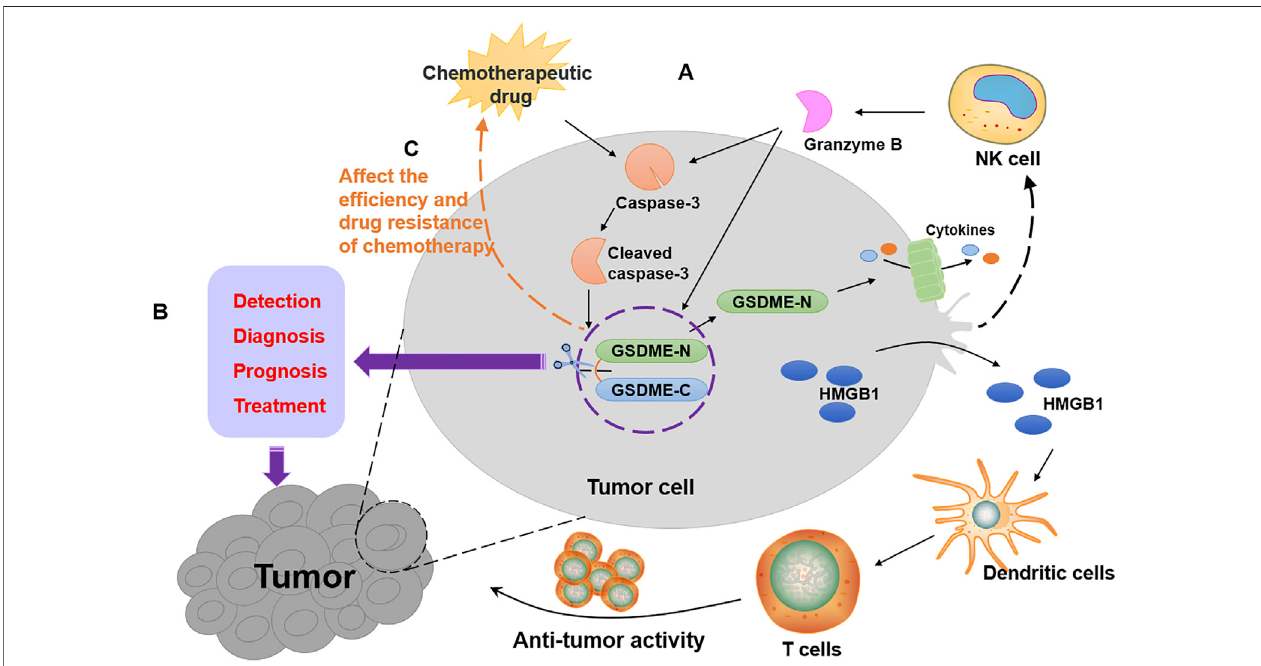
FIGURE 2 | The role of GSDME in tumors. (A) The ways of tumor suppression by GSDME as shown by the black arrows in the fi gure. Chemotherapeutic drugs activate caspase-3 to form cleaved caspase-3, which leads to the cleavage of GSDME. The GSDME-N targets cell membrane to form pores, resulting in cancer pyroptotic cell death. Furthermore, granzyme B released by NK cells not only activates caspase-3 but also directly cleaves GSDME to cause pyroptosis in GSDME- expressingtumors, which enhances the function oftumor-in fi ltratingimmunecells. Then, HMGB1 released bypyroptotic cell activates dendriticcells, which cause T cell proliferation to exert anti-tumor activity. (B) GSDME can be used for the detection, diagnosis, prognosis and treatment of cancer patients, as shown by the purple arrows in the fi gure. (C) The expression of GSDME affects the ef fi ciency and drug resistance of chemotherapy, as shown by the orange arrows in the fi gure.